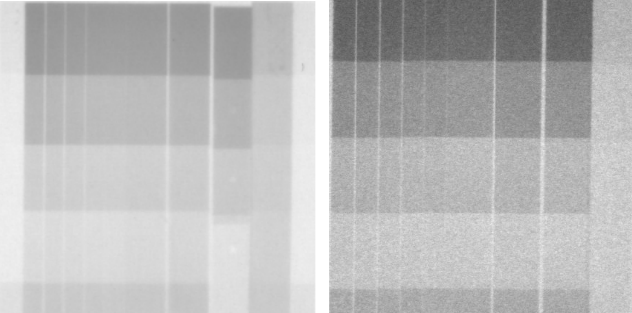
Fig. 9. The resulting image of the SI for the OB (left) and CB (right) configurations. Note: another SI has been used for the CB configuration that does not have the holes